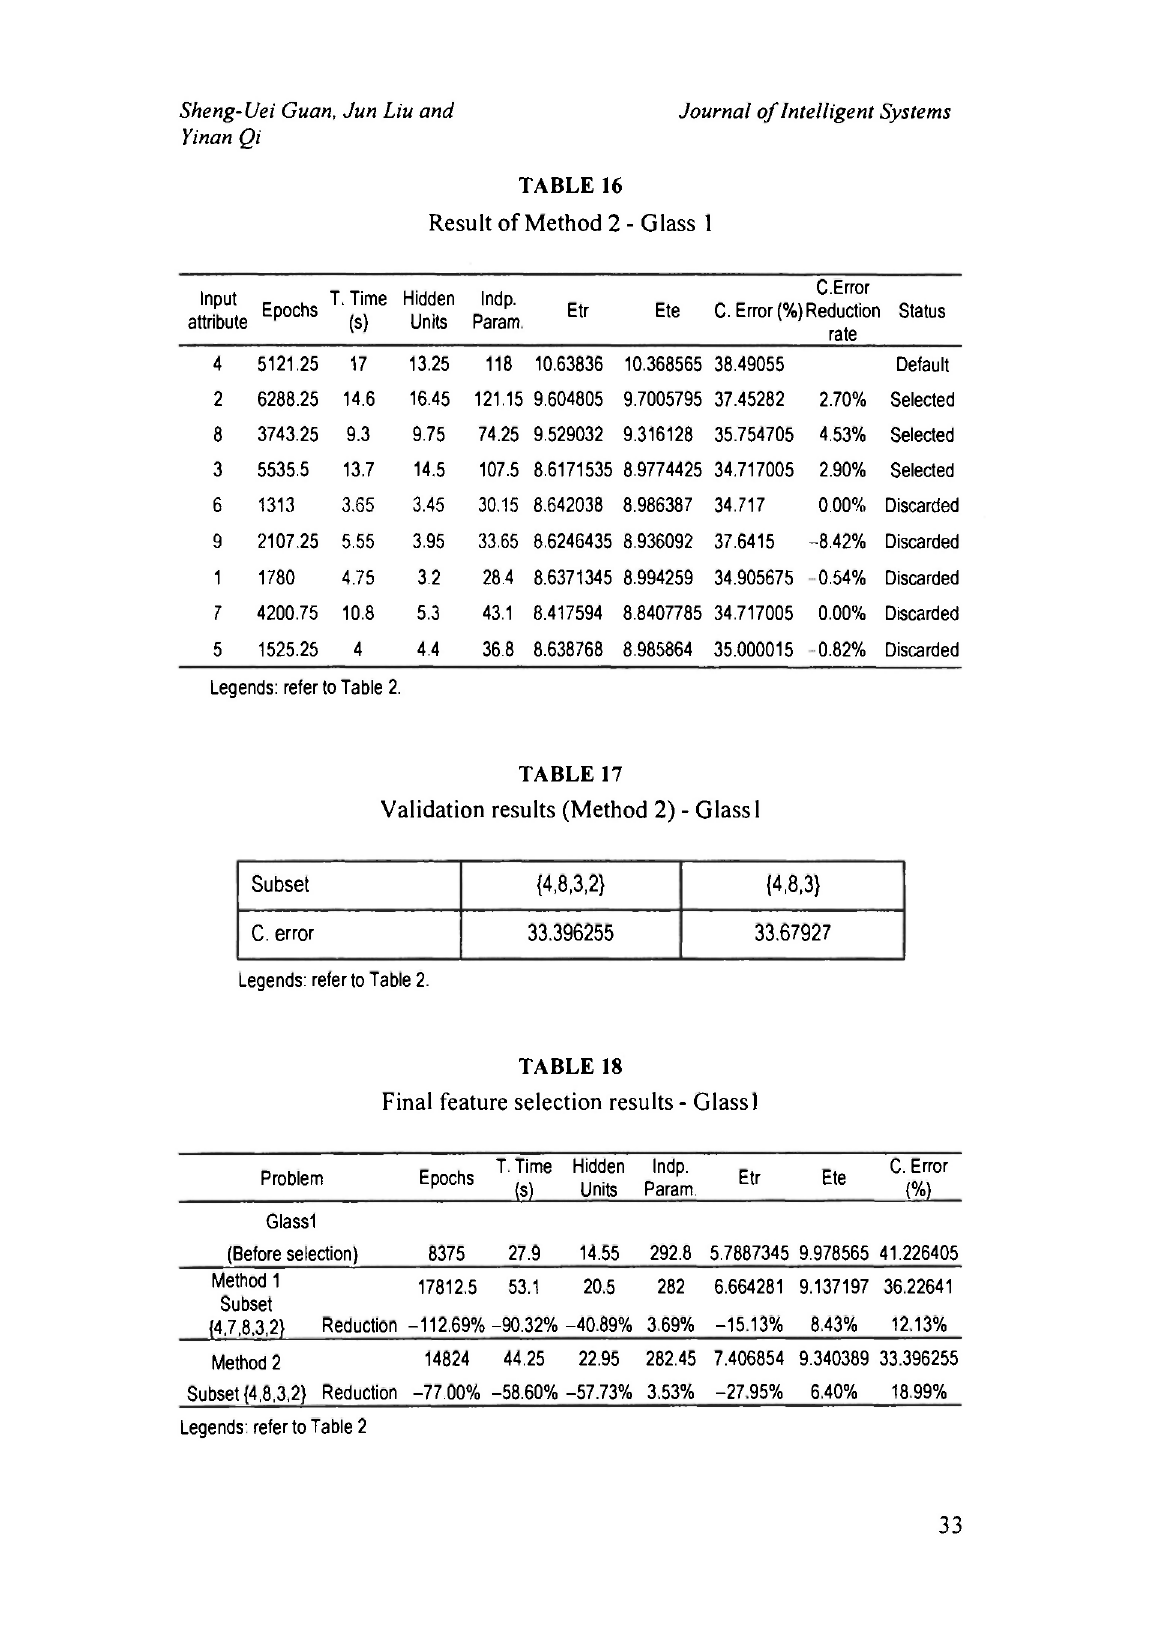
Result of Method 2 - Glass